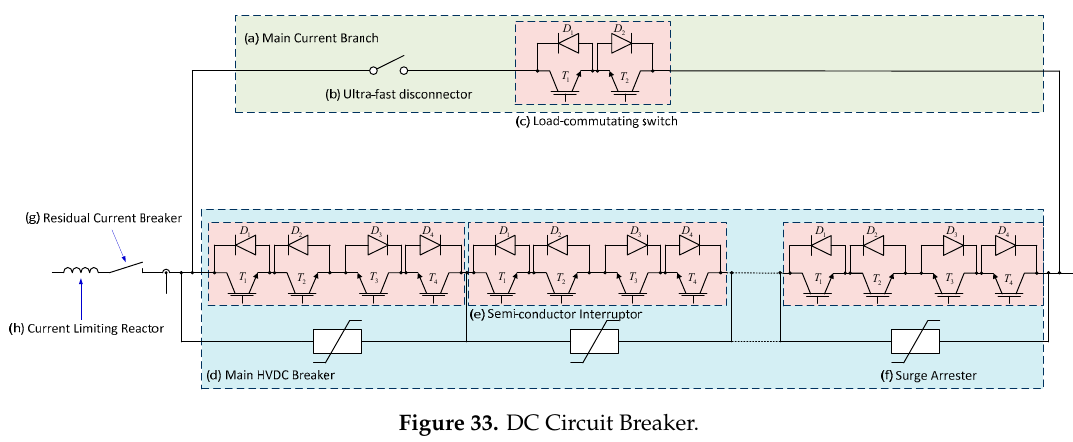
Figure 33. DC Circuit Breaker.